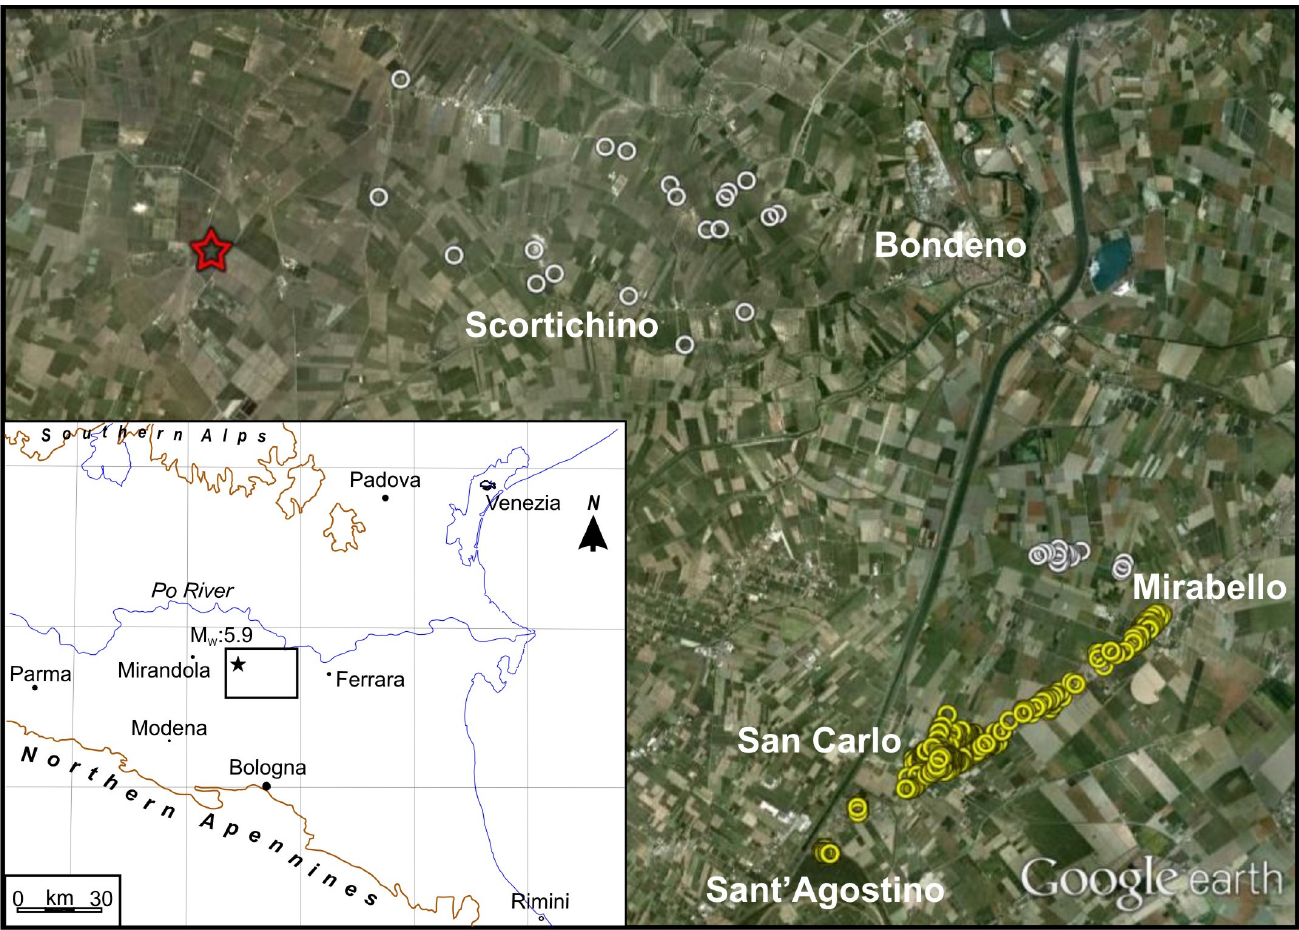
Figure 1. Map of the spatial distribution of the liquefaction-induced surface evidence within the west Ferrara Province from original data (yellow circles) and from the ISPRA [2012] report (white circles). Red star, May 20, 2012, earthquake epicenter. Base map from Google Inc.